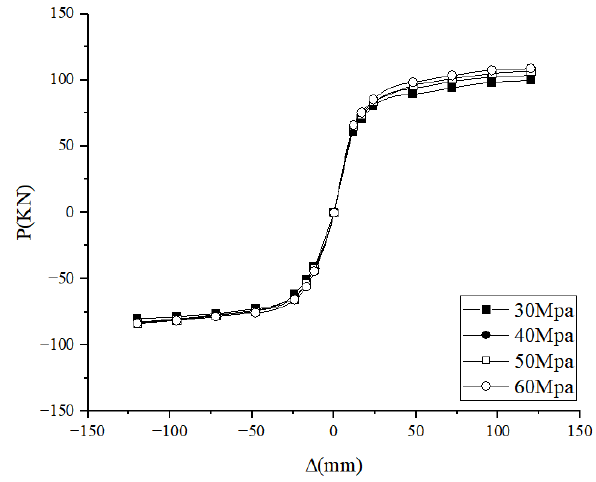
Figure 21. Strength of concrete in beam.